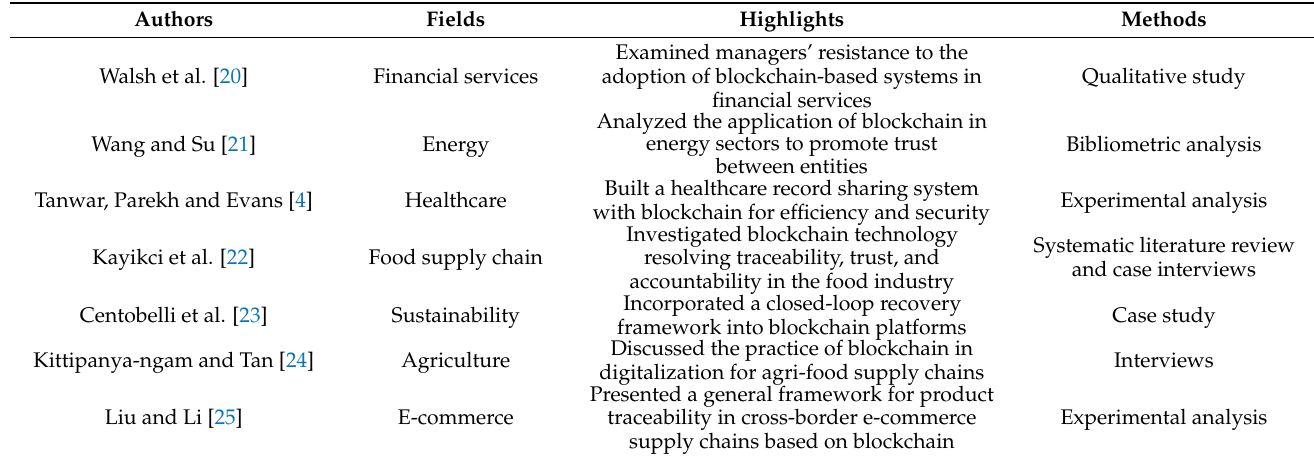
Table 1. Summary of blockchain applications in different